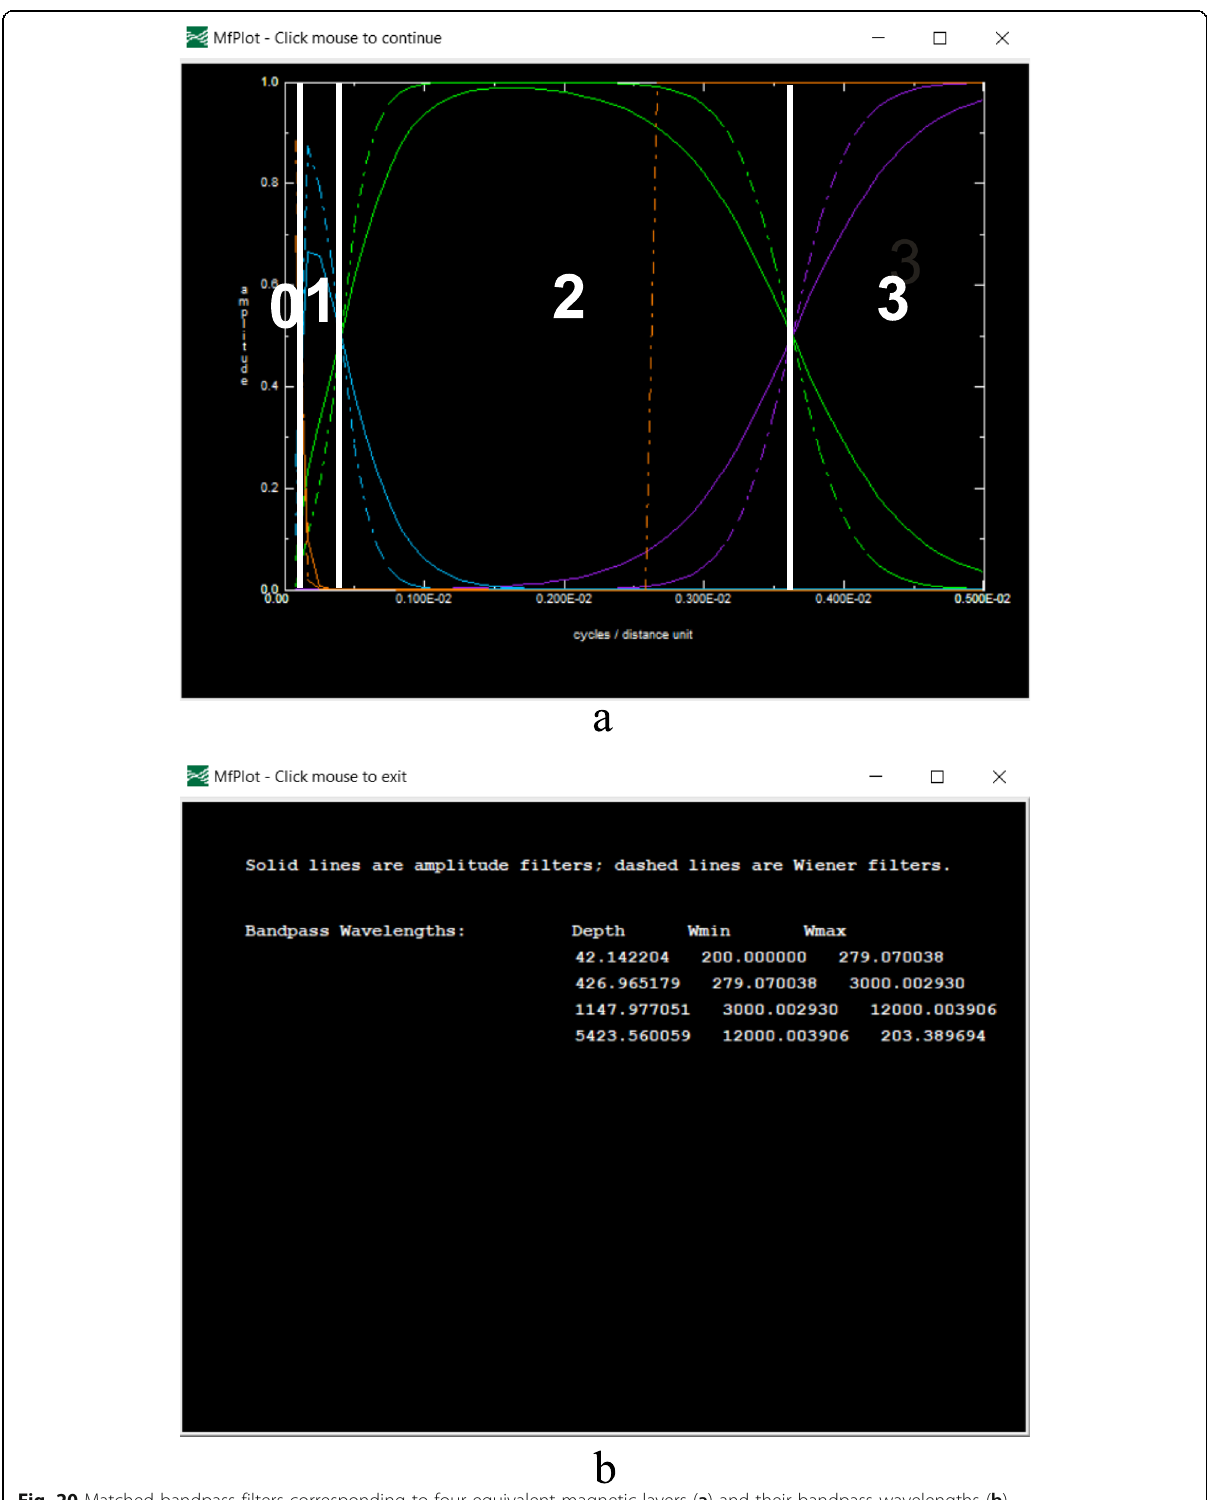
Fig. 20 Matched bandpass filters corresponding to four equivalent magnetic layers ( a ) and their bandpass wavelengths ( b